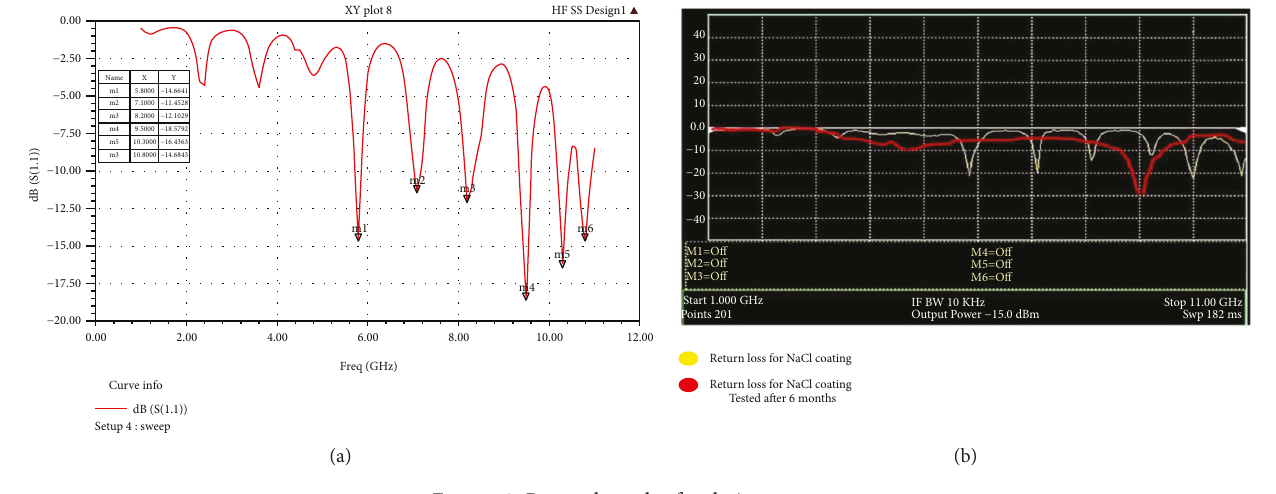
Figure 3: Return loss plot for design antenna.